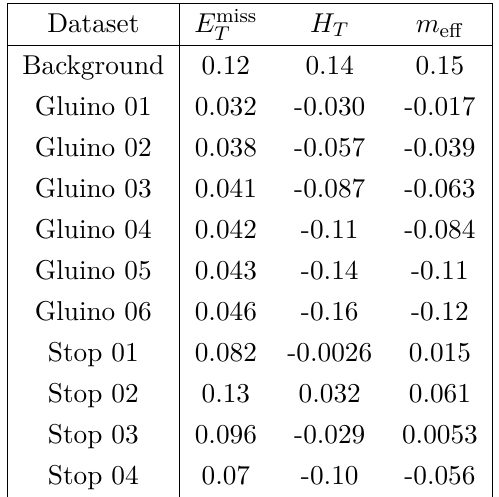
Figure 9 . ROC curves for the stop signals (table 1) for the algorithms applied on latent space representations. Labeling is the same as in figure 3.